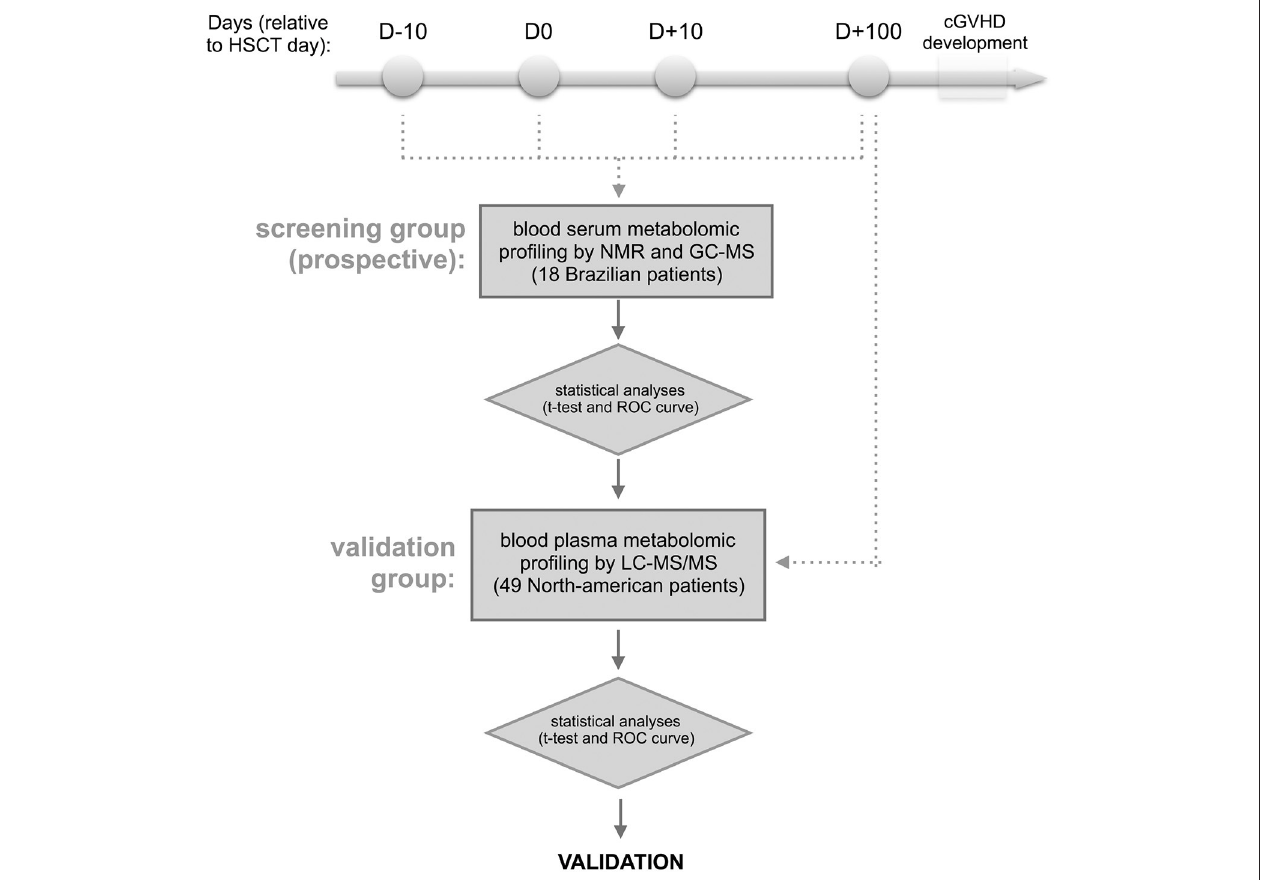
FIGURE 1 | Experimental design. The approach involves the targeted serum metabolic profiling (by NMR and GC-MS) of Brazilian patients undergoing allogeneic hematopoietic stem cell transplantation (discovery cohort). Blood serum samples were prospectively collected the day before starting the myeloablative conditioning regimen (D-10), HSCT day (D0), as well as 10 and 100 days after HSCT (D + 10 and D + 100, respectively). The retro-prospective statistical analysis (uni- and multivariate) aimed to create a panel of potential biomarkers for cGVHD. This panel was further validated in North American patients’ plasma collected at day + 100 by targeted metabolic profiling LC-MS/MS. Any patients showed aGVHD or cGVHD symptoms before or at sampling